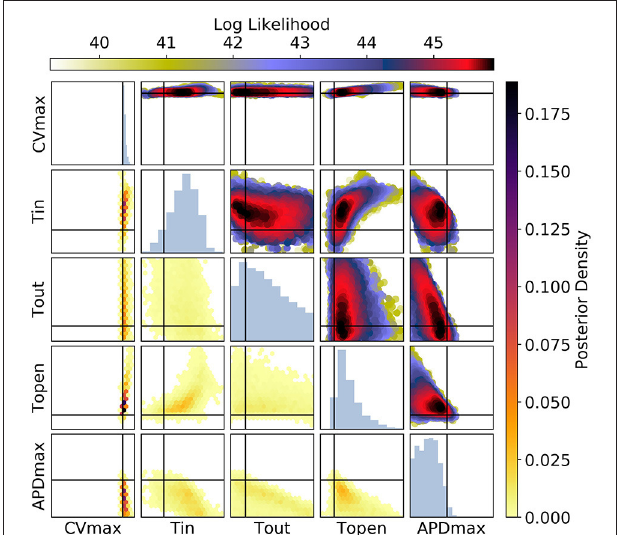
FIGURE 10 | The posterior parameter distribution for fits to CV(S2) and ERP(S1) measurements. The intersection of vertical and horizontal lines mark the true parameter value. The lower diagonal shows the density via hexbin plots, while the upper diagonal shows the log likelihood values for each sample plotted in order of increasing likelihood. The diagonals show the marginal histograms of each parameter.